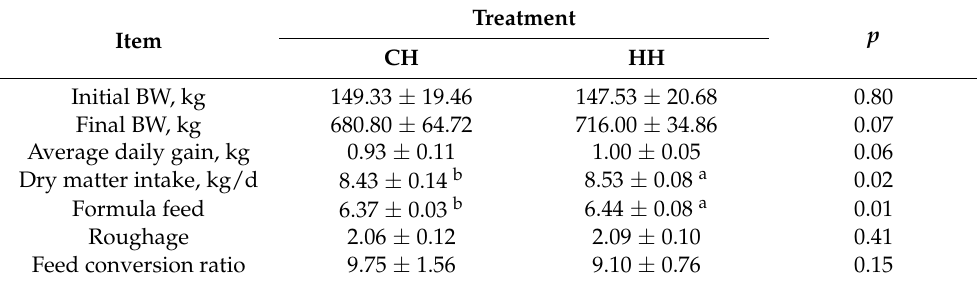
Table 2. Comparison of growth performance on castrated and hemi-castrated